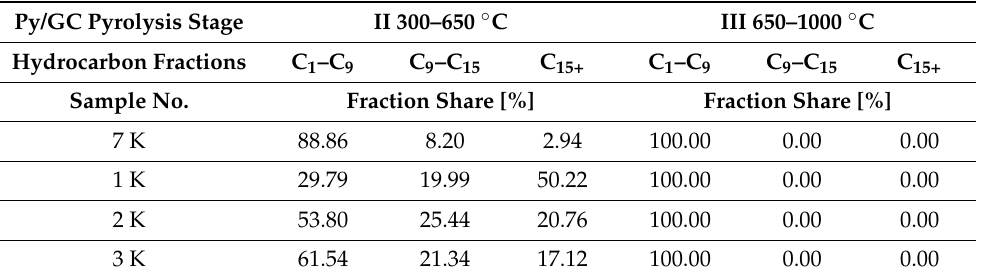
Table 6. Results of Py/GC analysis of kerogen isolated from selected Menilite Bed samples from surface